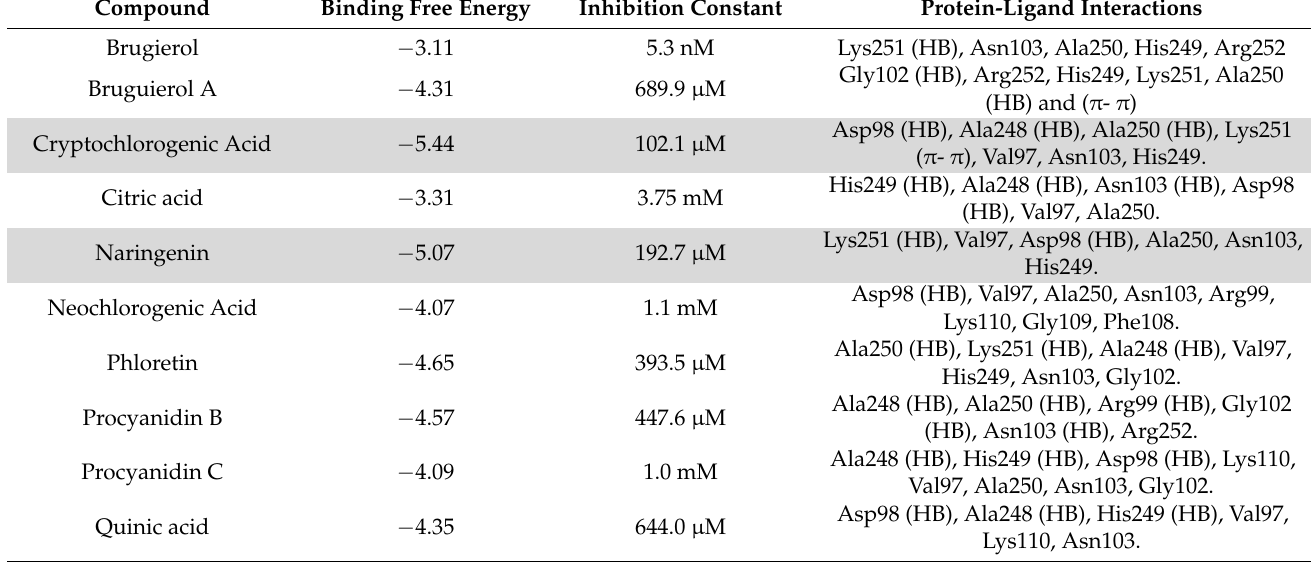
Table 5. Binding free energy (kcal/mol), calculated inhibition constant (K i ) and protein–ligand interactions of the listed compounds against ZIKV envelope protein using docking